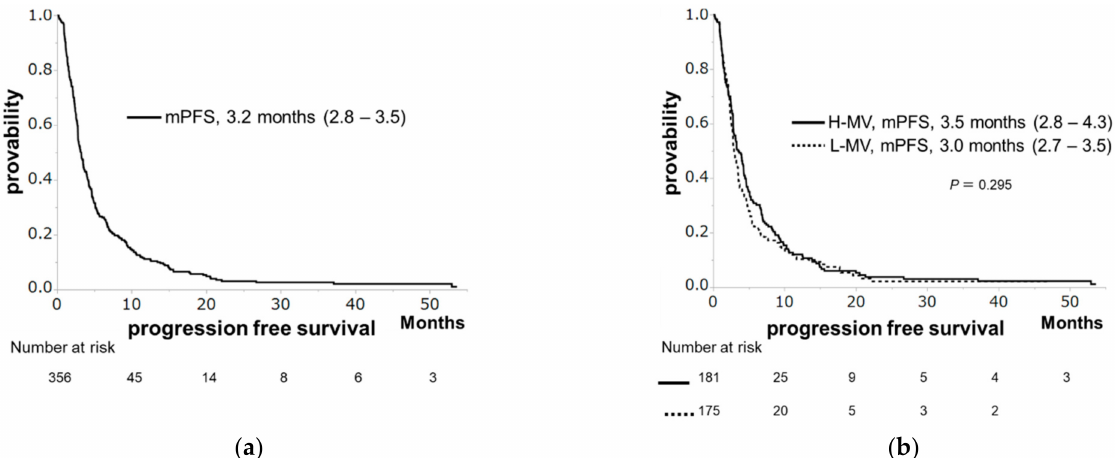
Figure 2. Progression-free survival (PPS) in hepatocellular carcinoma patients receiving sorafenib. ( a ) The PFS rates at 1 and 2 years are 11.2% and 3.1 %, respectively, with a median PFS of 3.2 months. ( b ) PFS according to skeletal muscle volume. No significant difference in PFS can be observed between patients with high muscle volume (H-MV) and those with low muscle volume (L-MV) (median PFS: 3.5 vs. 3.0 months, p =